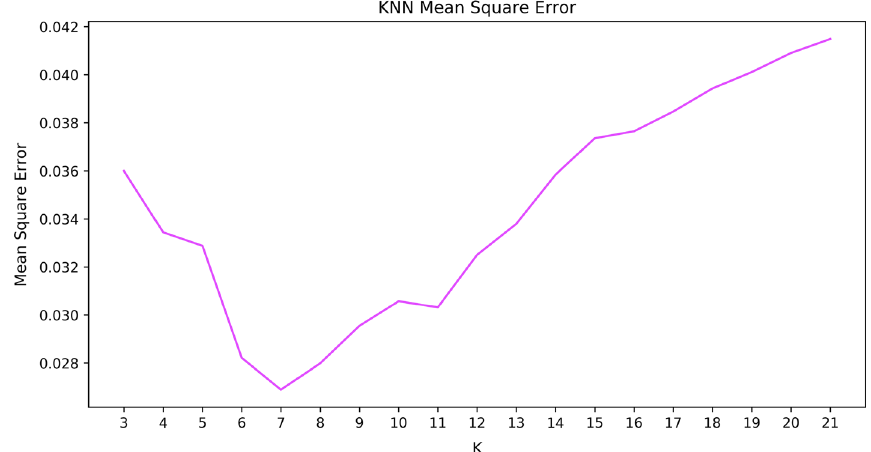
Fig. 3 KNN mean squared